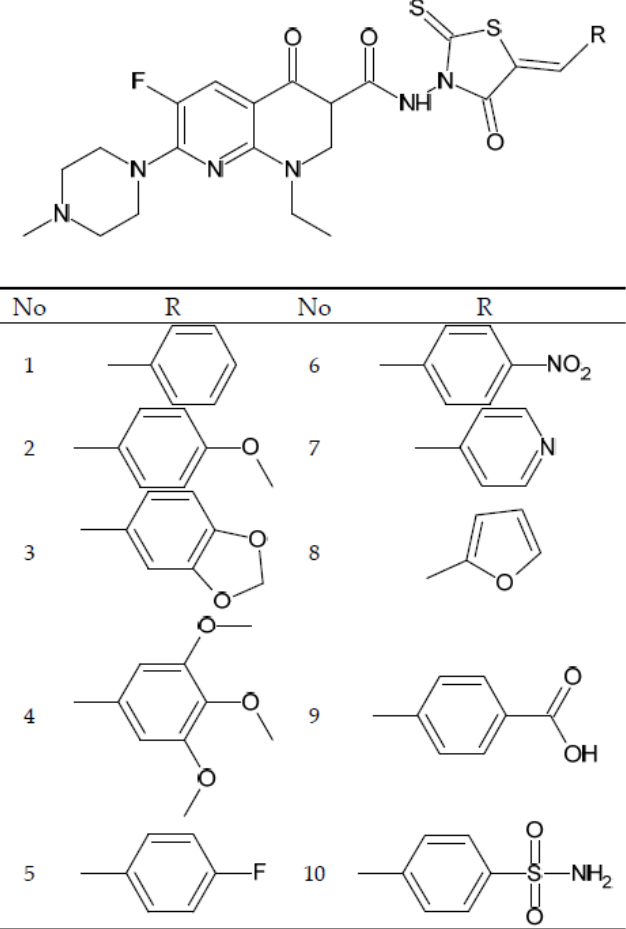
Figure 10. General structure of enoxacin alkyl derivatives prepared by Wang et al. [106].